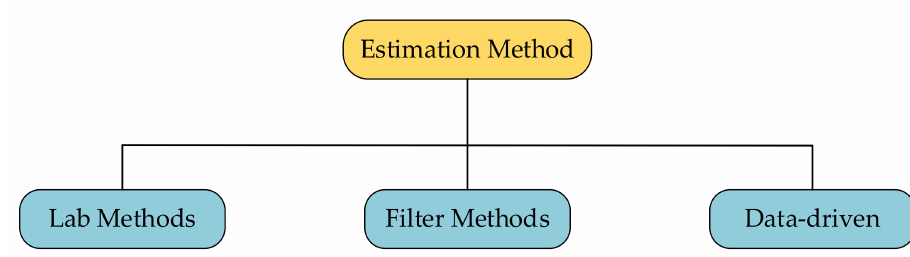
Figure 7. SOH-estimation methods